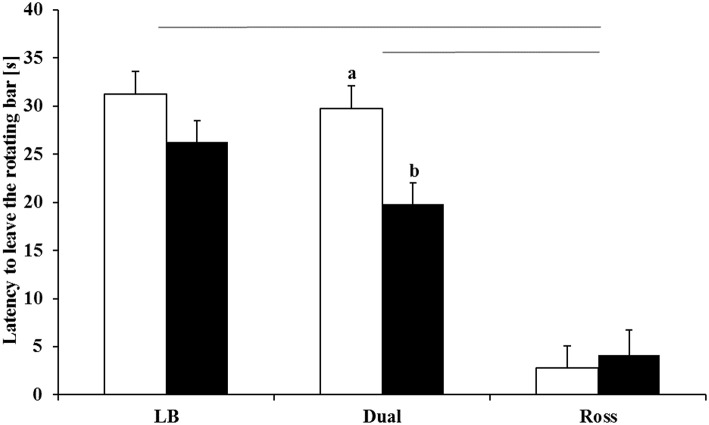
Latency to leave the rotating bar (LSM ± SE) in the rotarod test for LB, Dual, and Ross chickens housed with (enriched, white bars) and without (control, black bars) elevated structures. Significant differences between enriched and control pens are marked by different letters (P < 0.05). Significant differences between strains and treatments are marked by lines (P < 0.05).